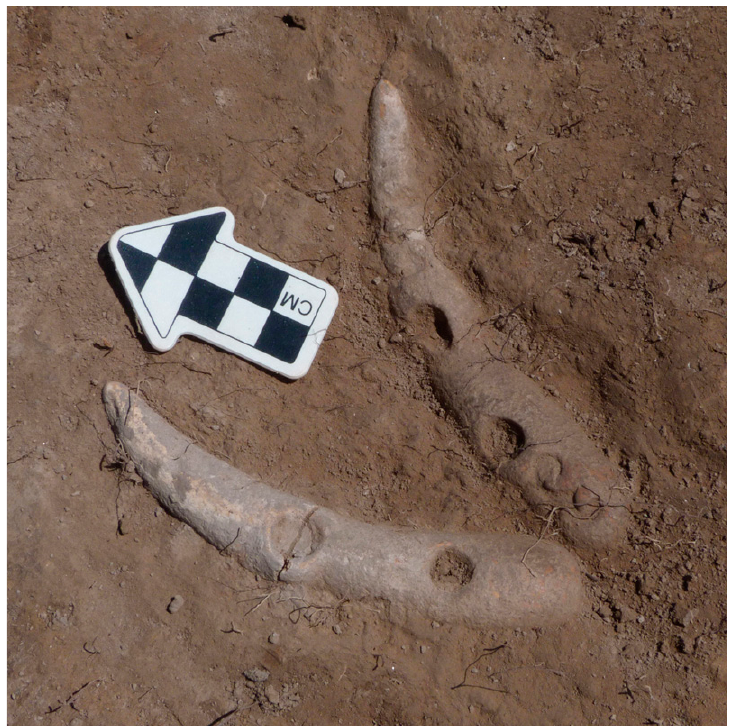
Figure 7. Horn cheek pieces from Tuzusai.